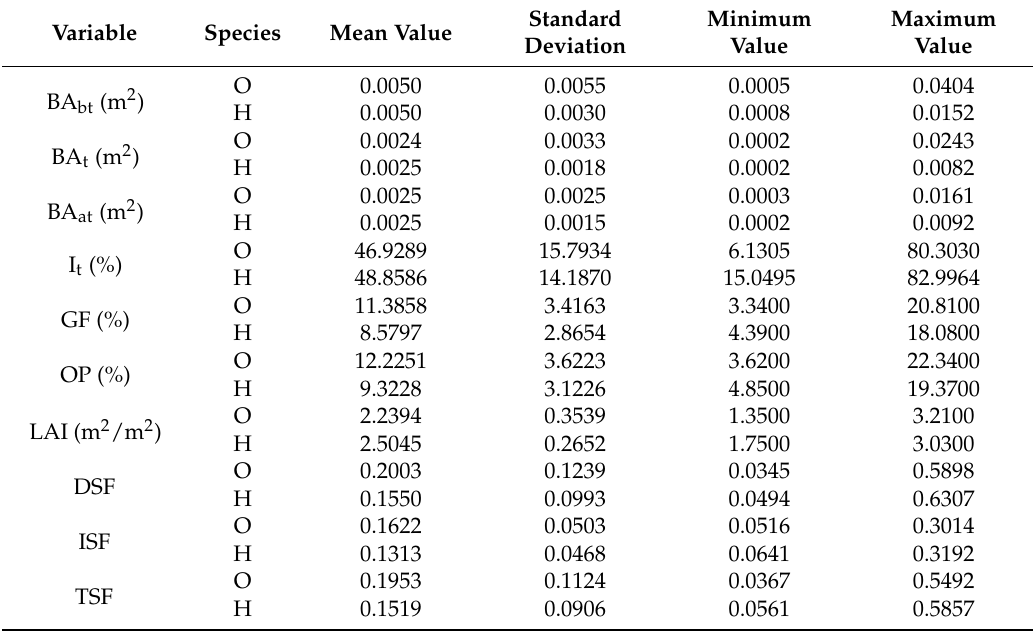
Table 1. Basic characteristics of selected variables measured at stool level.